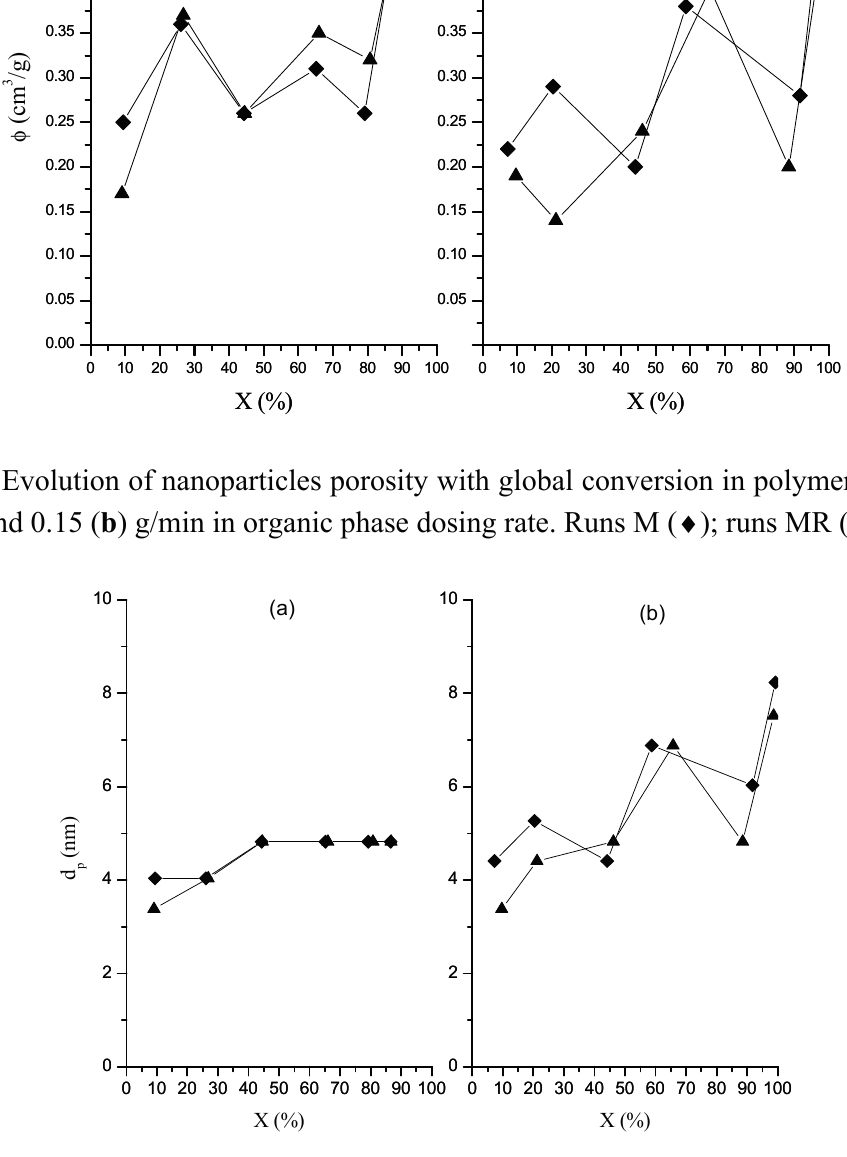
Figure 7. Change of pore diameter in nanoparticles with global conversion in polymerizations at 0.05 ( a ) and 0.15 ( b ) g/min in organic phase dosing rate. Runs M ( ♦ ); runs MR ( ▲